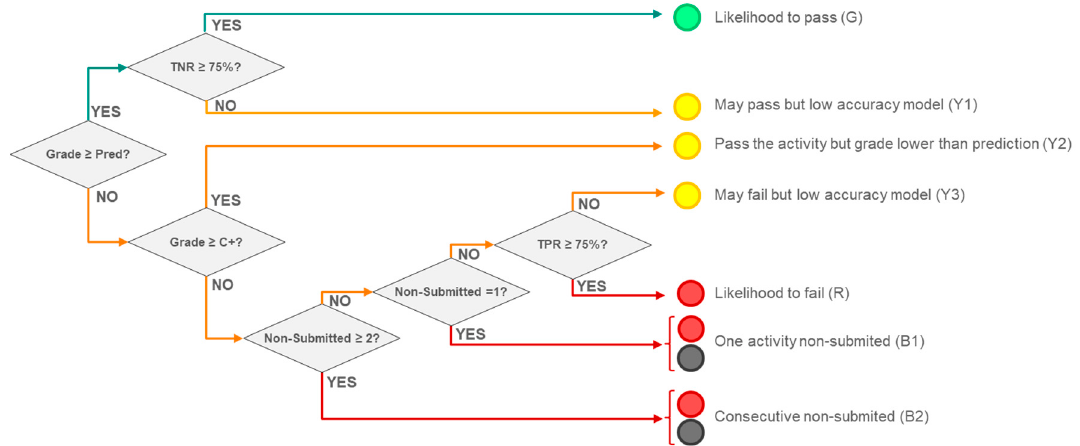
Figure 7. Decision tree for warning level classification.